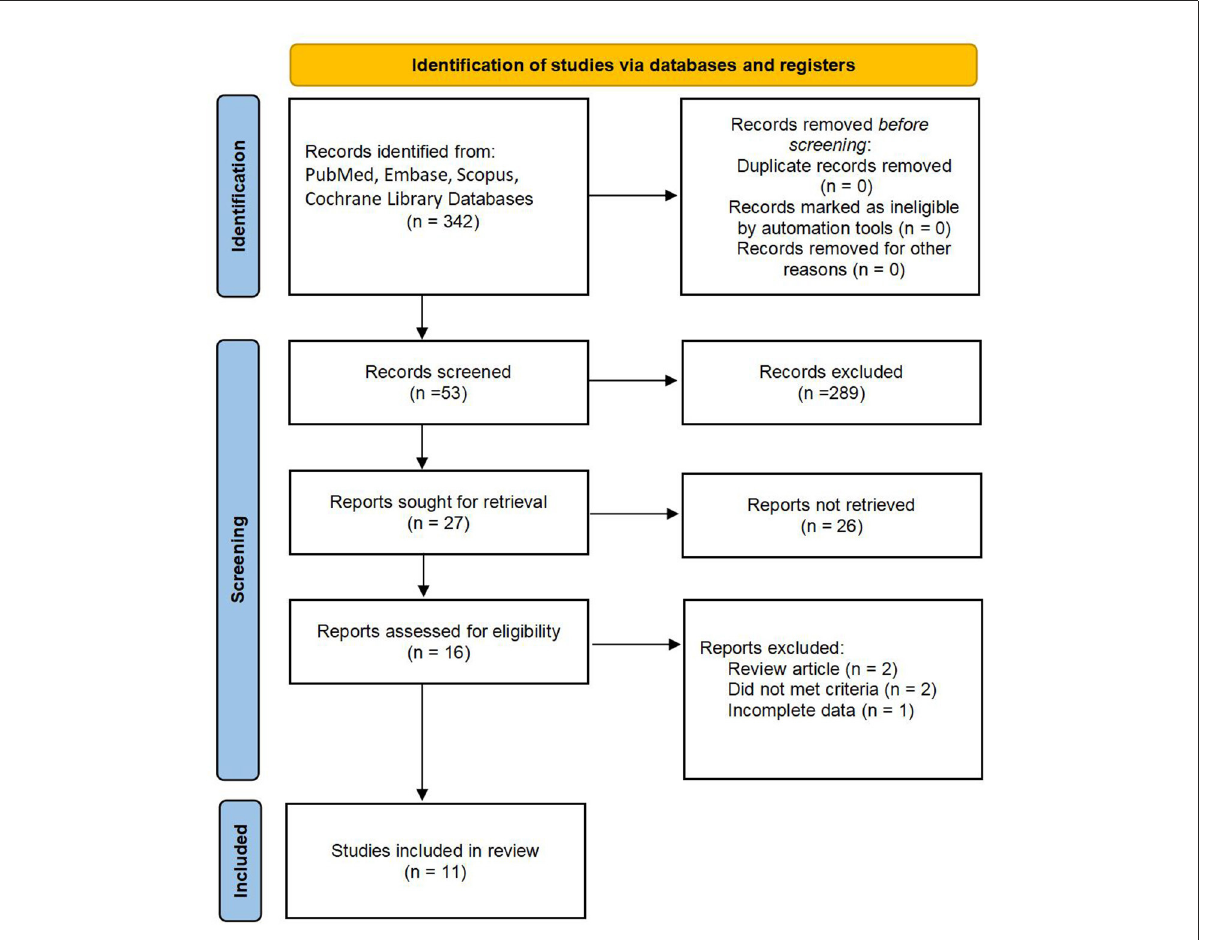
FIGURE1 Flow diagram of the studies selection process.